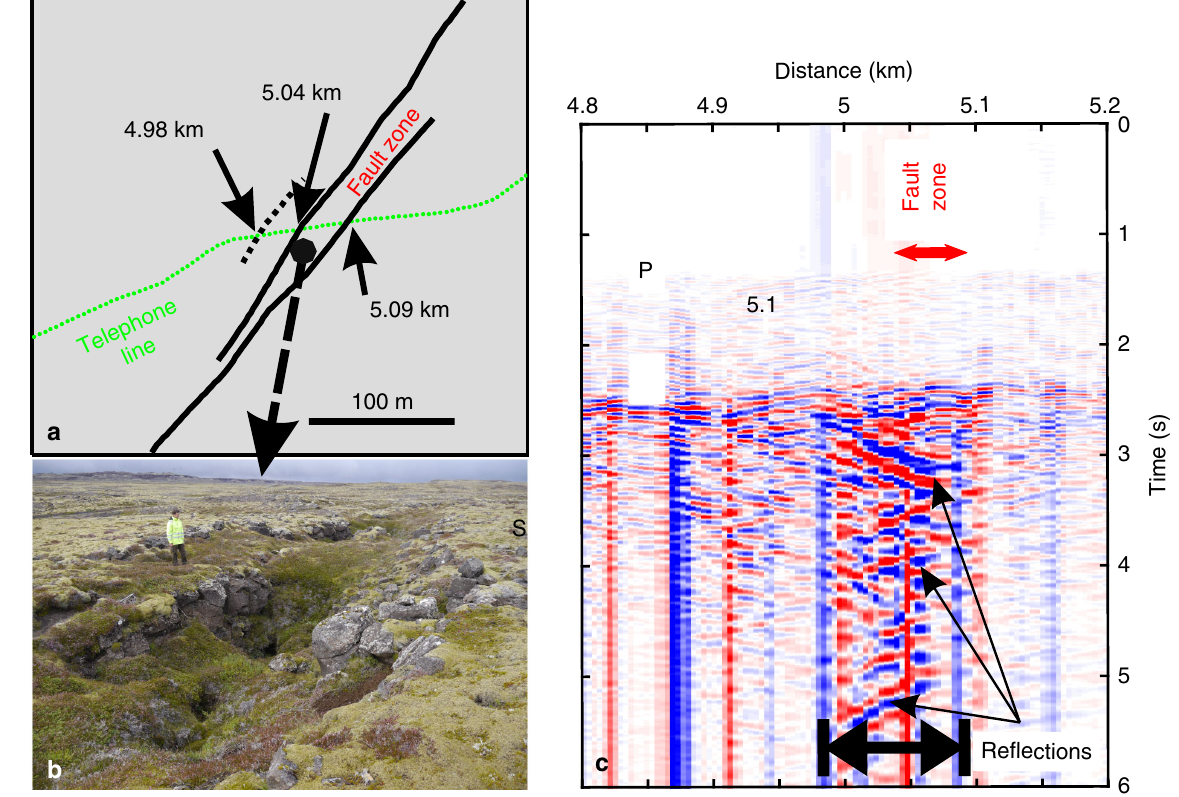
Fig. 7 Structure of a fault damage zone within an active geological rift. a The road and the cable (distance ~5 km) cross several faults, e.g. a clearly visible fault zone with more loose material in the fi eld (between 5.04 and 5.09 km). b The fault damage zone is visible by the ~50 – 60 m wide depression area (picture taken at ~100 m SW of the road, looking towards SW). Note that at the cable location no depression area is visible. The depression is only the surface expression at the position of the picture (Picture Martin Lipus, GFZ). c Short record (6 s) of strain phases from a local earthquake (Fig. 5) trapped in the fault damage zone. Phases are re fl ected until ~4.98km, which may indicate a hidden fault with surface expression. Waves inside and outside the fault zone have different apparent